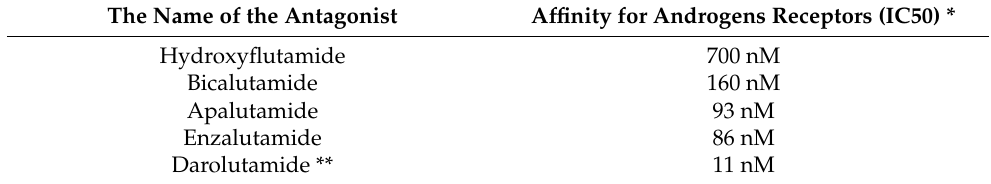
Table 1. Selected nonsteroidal inhibitors of androgen receptors. The Name of the